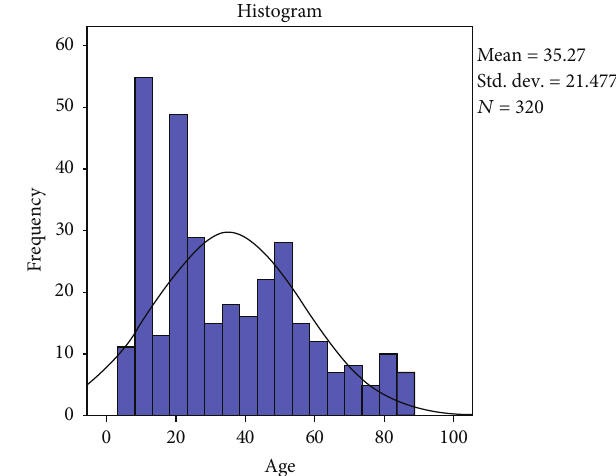
Figure 1: Age distribution of the